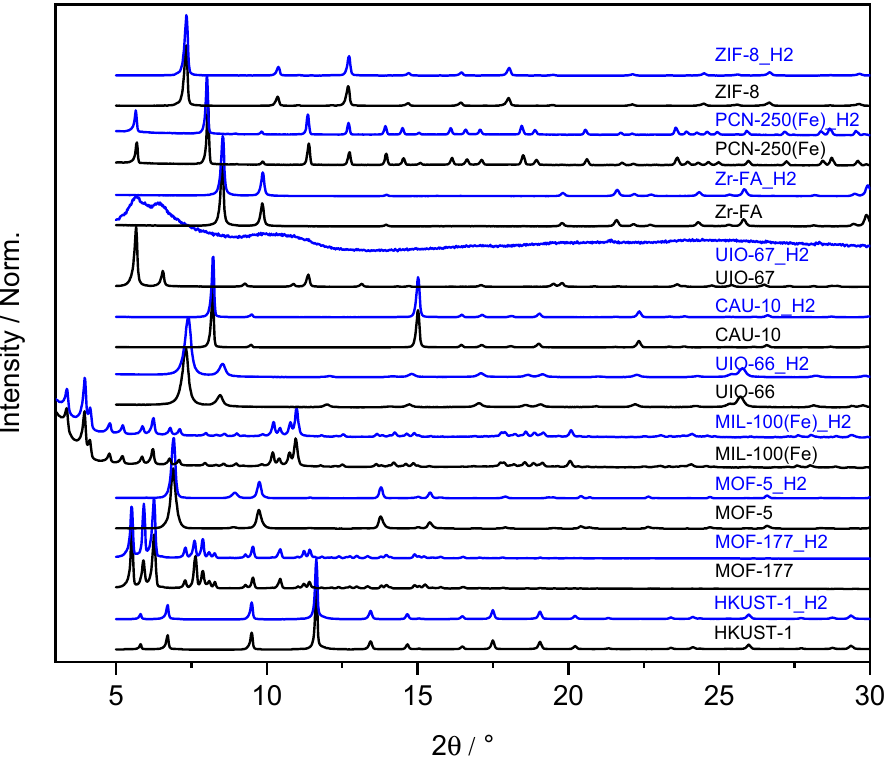
Figure 2. PXRD of MOFs before (black lines) and after (blue lines) the hydrogen adsorption experiment.